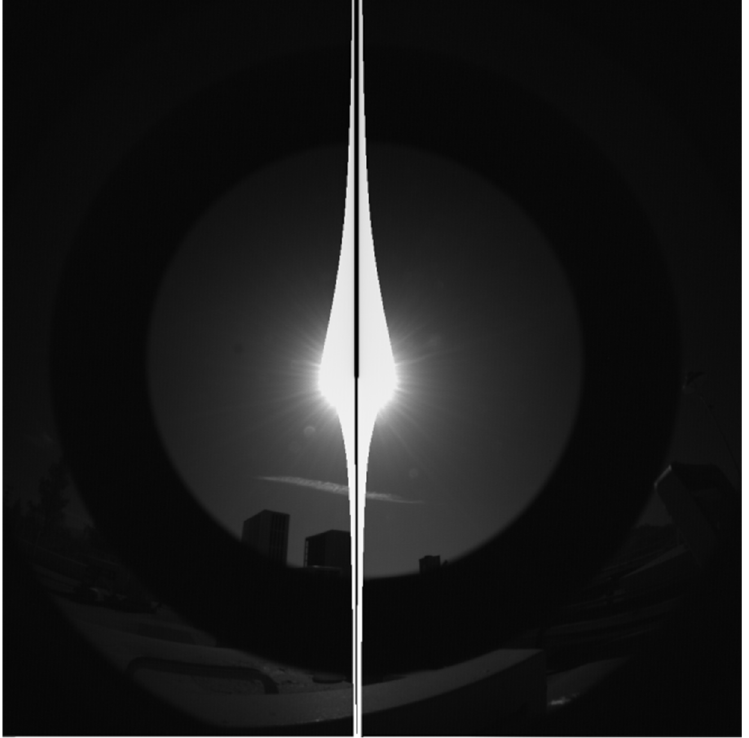
Figure 14. RDS-SkyCam image of Earth sky with new optic. Significant improvement over inherited design.